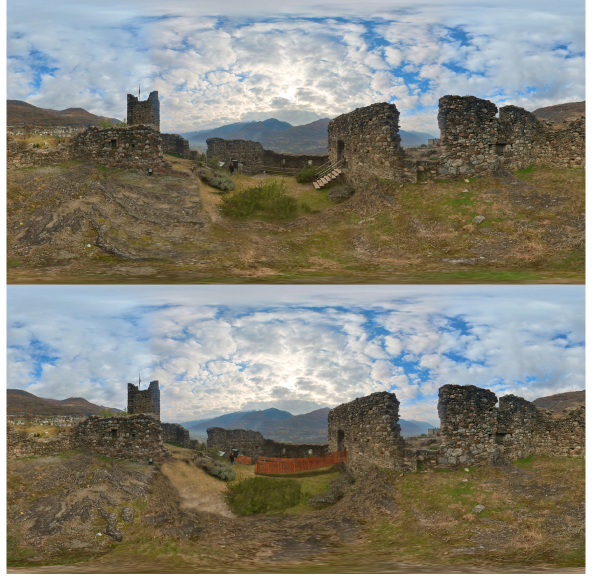
Figure 4: Top: Original equirectangular protection acquired with a low-cost 360° camera (Insta360 One R). Bottom: rendered re- sult in which a ramp was added in the center of the image to replace existing stairs.